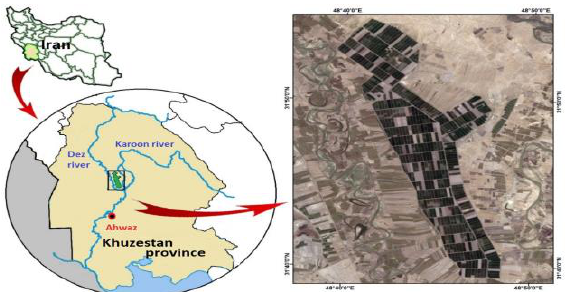
Table 1. 16 Landsat 8 images used for calculating vegetation indices of